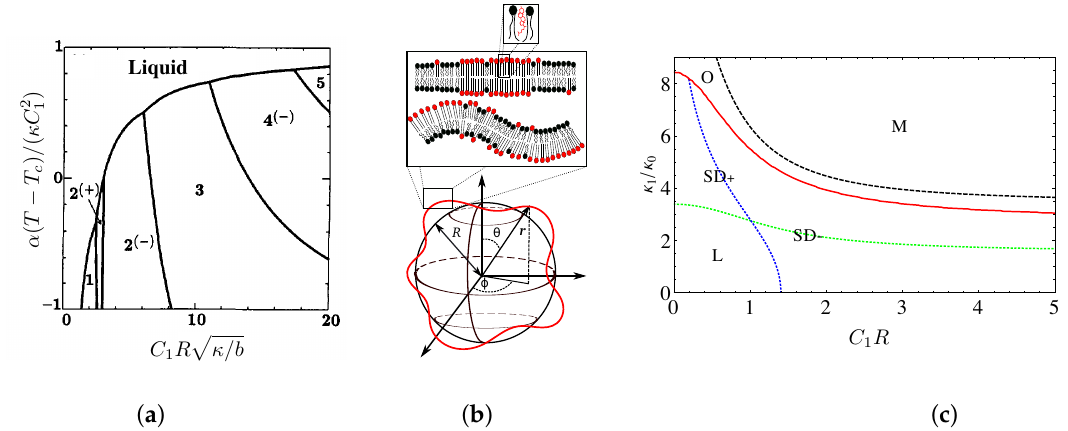
Fig. 5. Phase diagrams of3dvesicleswith no spontaneous curvature (fi~~ 0 ), are shown (a) inthe with b~0, I,e. (T 7j and (b) (b~ (T), $~ ~'~ with fi 0. The numbers and parameter plane ~ji, i~ "~) the ( ± superscript standforthe most stable modes and the sign of i~i, respectively. « Homogeneous » state with a perfectsphericalshape. For fimfi~ =6, the modeselectionis means the disordered Figure 3. Examples of phase diagram showing the formation of curvature induced domains in vesicles. difference inthe same way as single-component vesicles [2-4,34, 35], and determined by the pressure ( a ) AT high T or low C 1 , the liquid phase is homogeneous; numbered regions correspond to modulated (C~ ~ 0) isselected as is seen fromthe criterion (4.15). where the f = 2~+~ mode phases with the number of the most stable (cid:96) -mode ( (cid:96) = 1 to 5 here; (cid:96) = 1 corresponds to the macrophase separation). The superscript corresponds to the sign of C 1 . The bending modulus κ does not depend on the order parameter φ in the model. In this case, C 0 = ∆ p = 0. Adapted from [104]. ( b ) Sketch of a quasi-spherical vesicle with two different types of lipids inducing either thicker (with a larger bending modulus κ 0 + κ 1 ) or curved patches with a local spontaneous curvature C 0 + C 1 . ( c ) Associated phase diagram in the ( C 1 R , κ 1 / κ 0 ) plane. The symbols have the same signification as in Figure 2a. ( b ) and ( c ) are reproduced from [85], with permission of The European Physical Journal (EPJ), Copyright